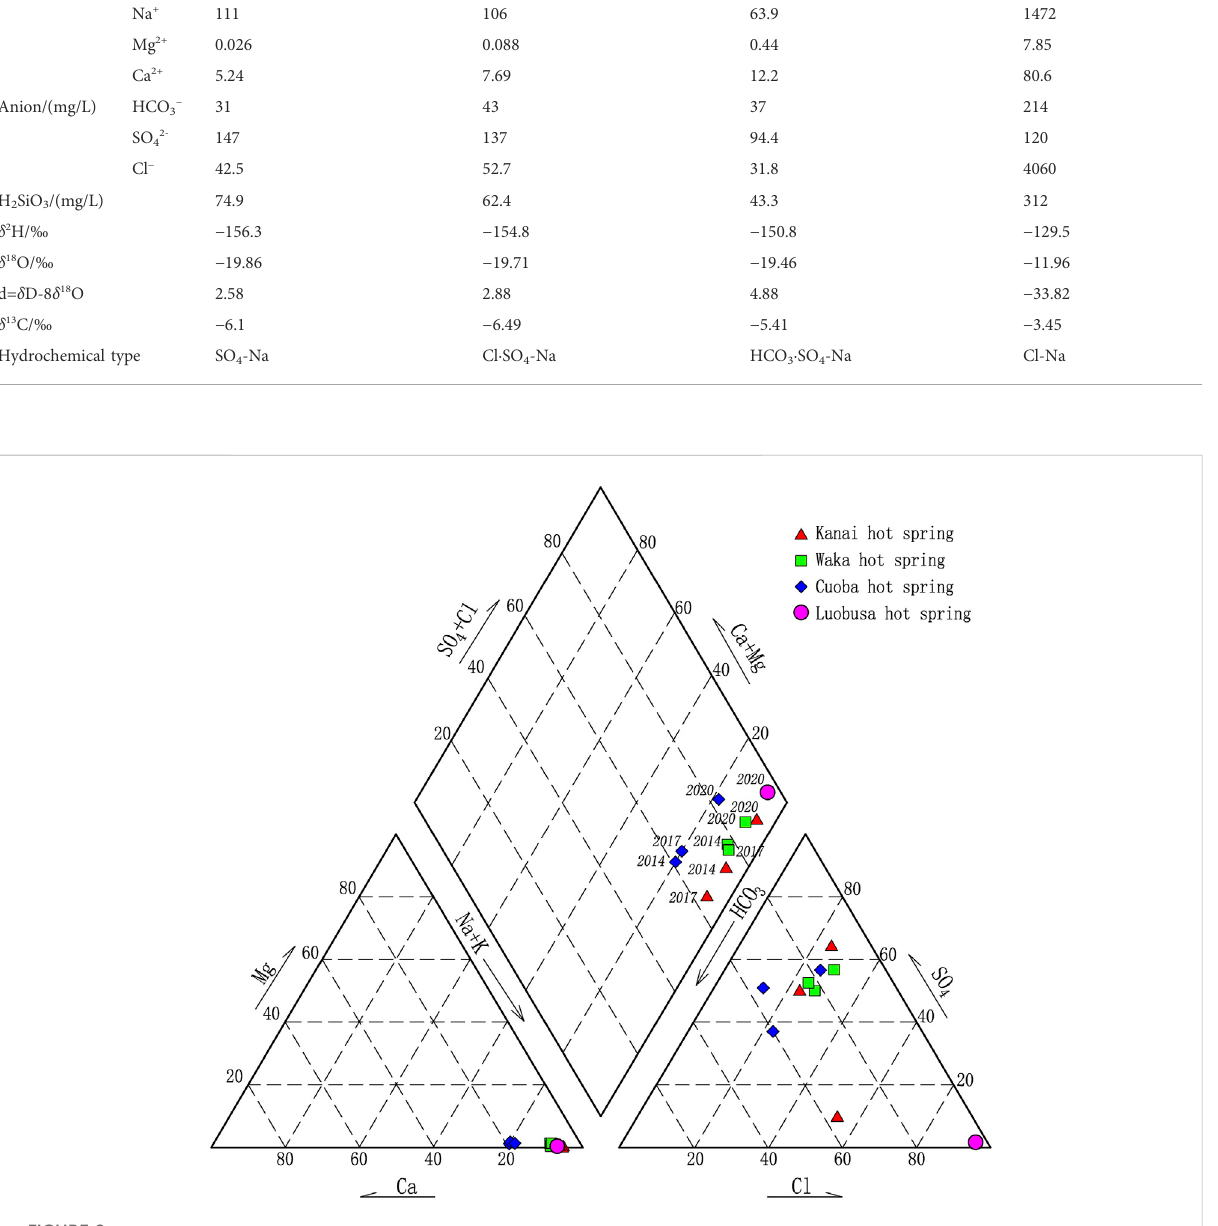
FIGURE 2 Piper diagram of geothermal